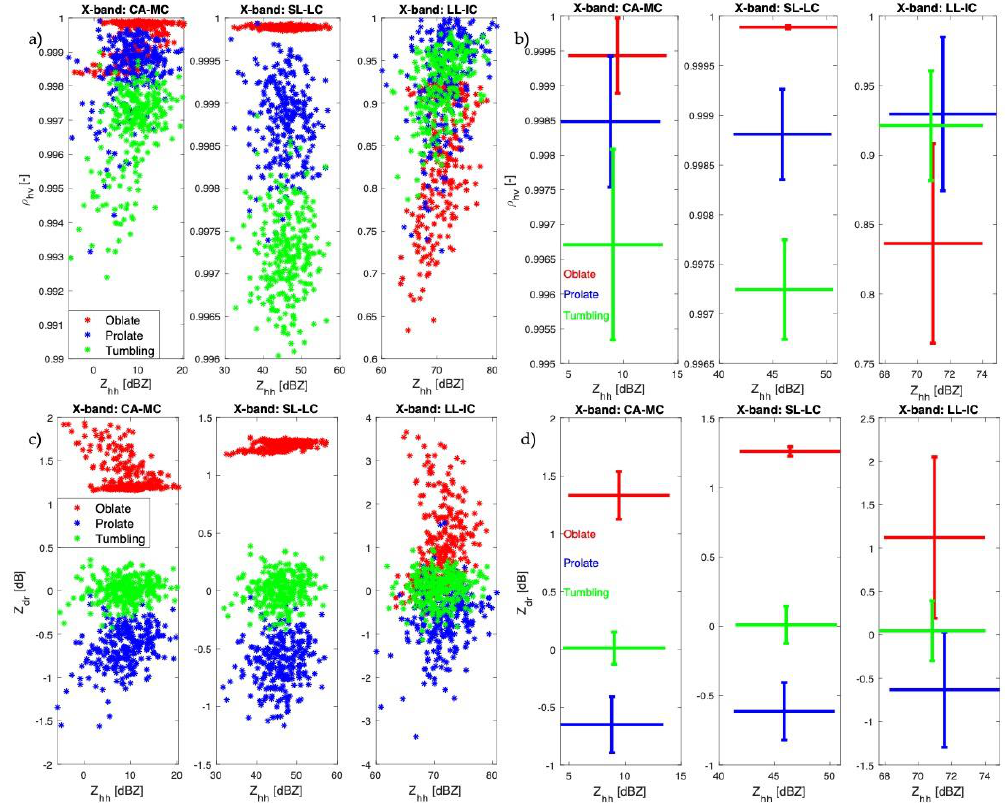
Figure 4. In panels ( a , c ) distribution of scatterplots of Z hh (dBZ) as a function of hv (adim) and Z dr (dB), respectively, whereas in panels ( b , d ) the statistic trend of same observables. The intersection of bars represents the mean value and the bar the standard deviation of each radar polarimetric observable, where the different colors refer to particle average orientations: oblate ( red ), prolate ( blue ) and tumbling ( green ).